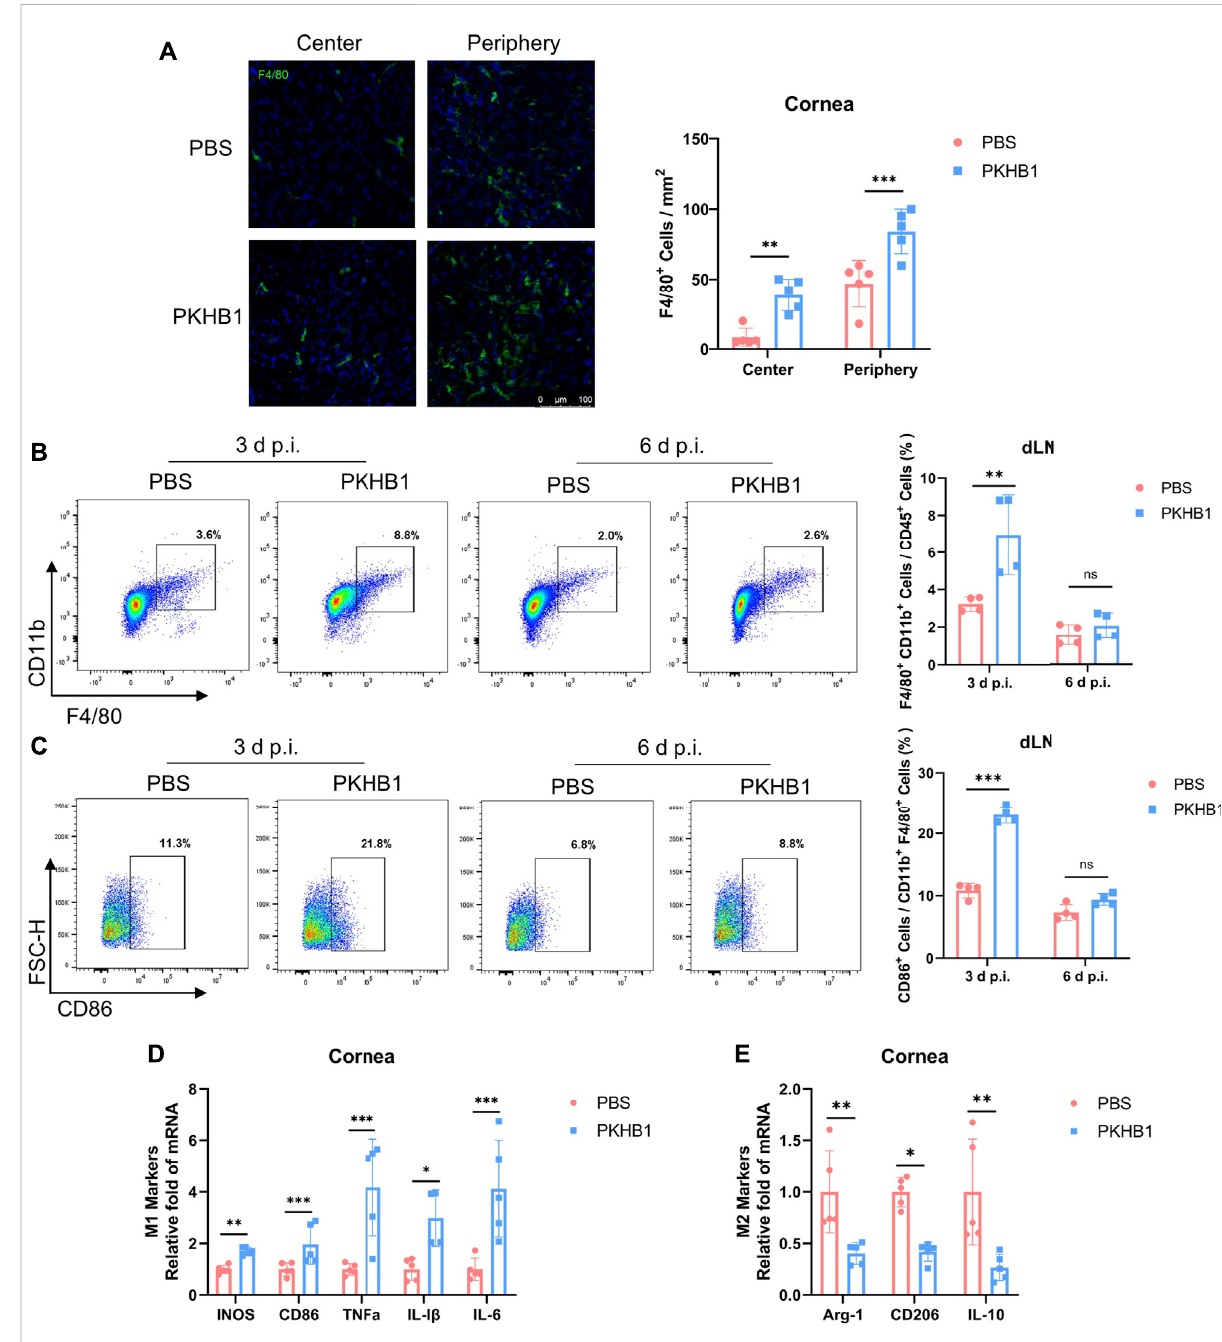
FIGURE 3 Subconjunctival injection of PKHB1 peptide increased the number of macrophages on the ocular surface and in the dLNs. (A) Representative micrographs (20 ×) of F4/80 (macrophages maker) expressing cells in the central and peripheral cornea ( n = 5). Bar charts showing the density of macrophagesinthecorneaineachtreatmentgroup.Representative fl owcytometryplotsandbarchartshowingthefrequencyofCD45 + CD11b + F4/ 80 + cells (B) and CD86 + cells (C) in the dLNs of PKHB1 peptide or PBS-treated mice at 3 d p.i. and 6 d p.i. ( n = 4). PKHB1 peptide increased the number of macrophages in the dLNs in the early stage of infection. The expression levels of genes for M1 (D) and M2 (E) macrophages polarizing cytokines in mice corneas at 3 d p.i. were measured by qRT-PCR ( n = 5). GAPDH was used as an internal reference. Data were presented as mean ± SD of three independent experiments. (* p < 0.05, ** p < 0.01, *** p <